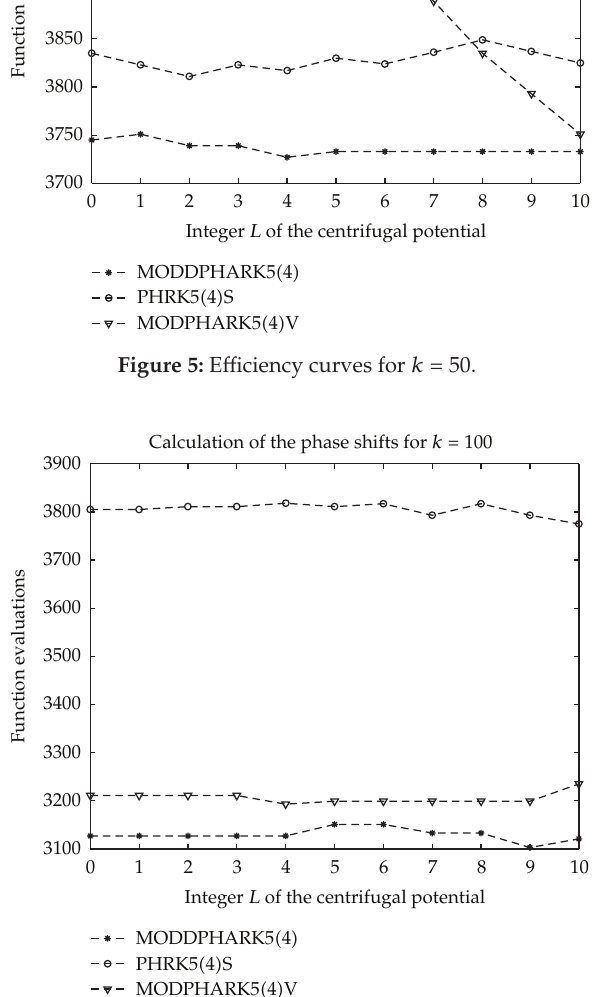
Figure 6: E ffi ciency curves for k (cid:7)